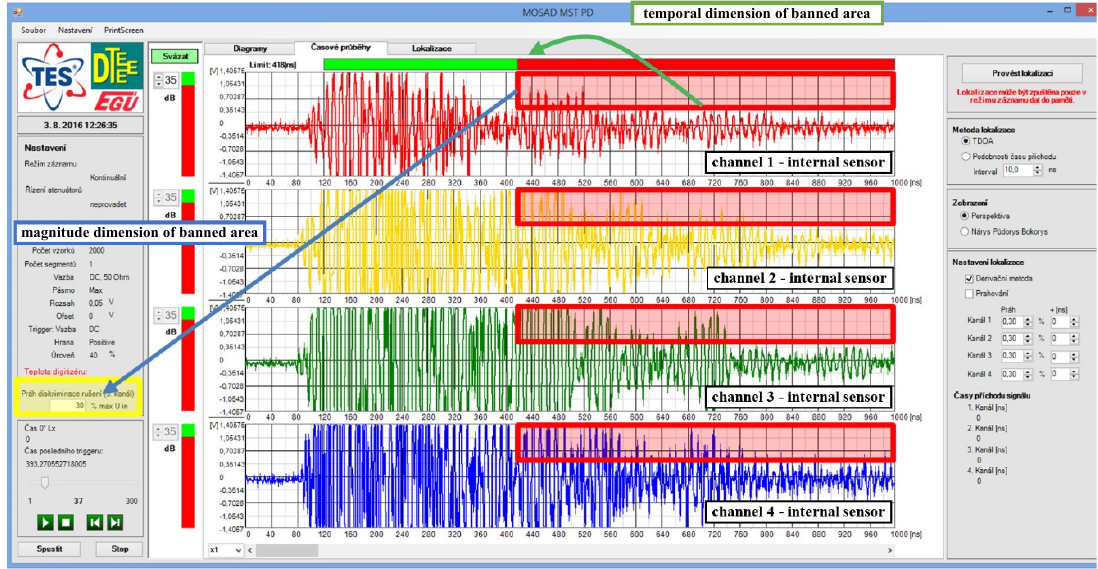
Figure 24. The discrimination based on the signals' temporal dispersion.